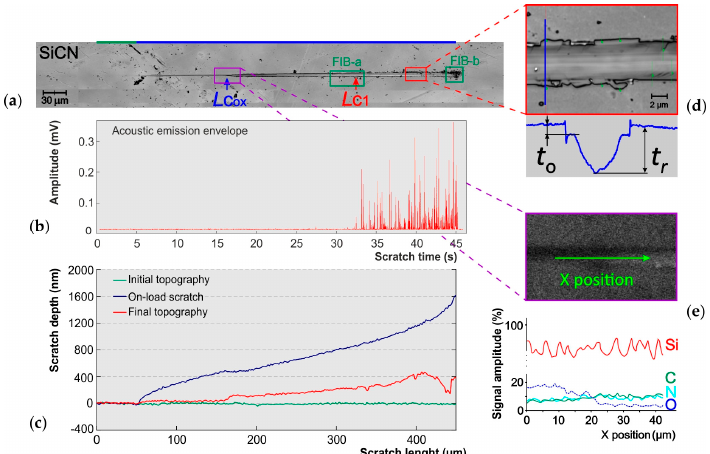
Figure 4. Detailed analysis of selected scratch test on sample SiCN with an oxidized surface using ( a ) microscopic record, ( b ) the acoustic emission record and ( c ) the depth change record. Detail ( d ) shows profile measurement of SiO x oxide film thickness and detail ( e ) shows the oxide SiO x film first penetration using the SEM-EDS linear mapping.